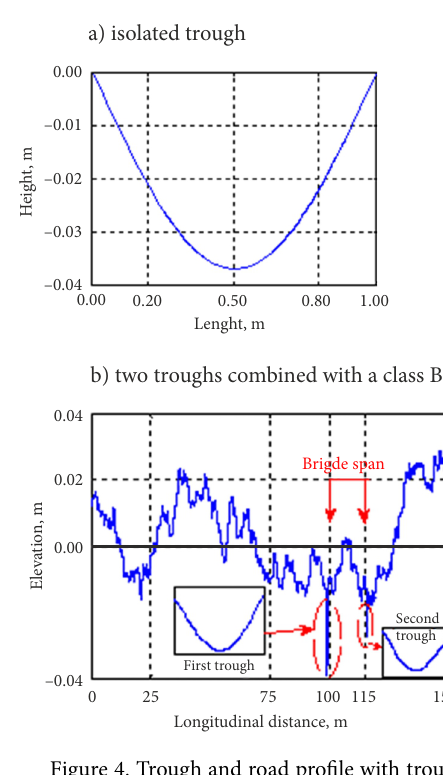
Figure 4. Trough and road profile with